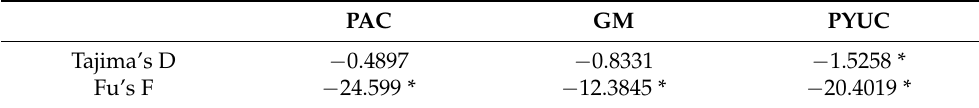
Table 2. Demographic analyses for Natalus mexicanus .